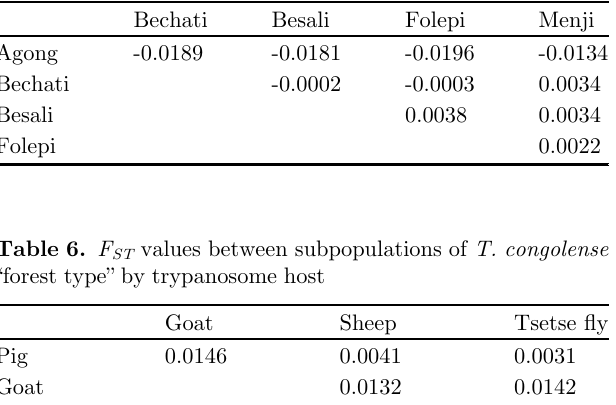
Table 5. F ST values between subpopulations of T. congolense “ forest type ” by village Bechati